Question: In one sentence, what is this figure communicating?
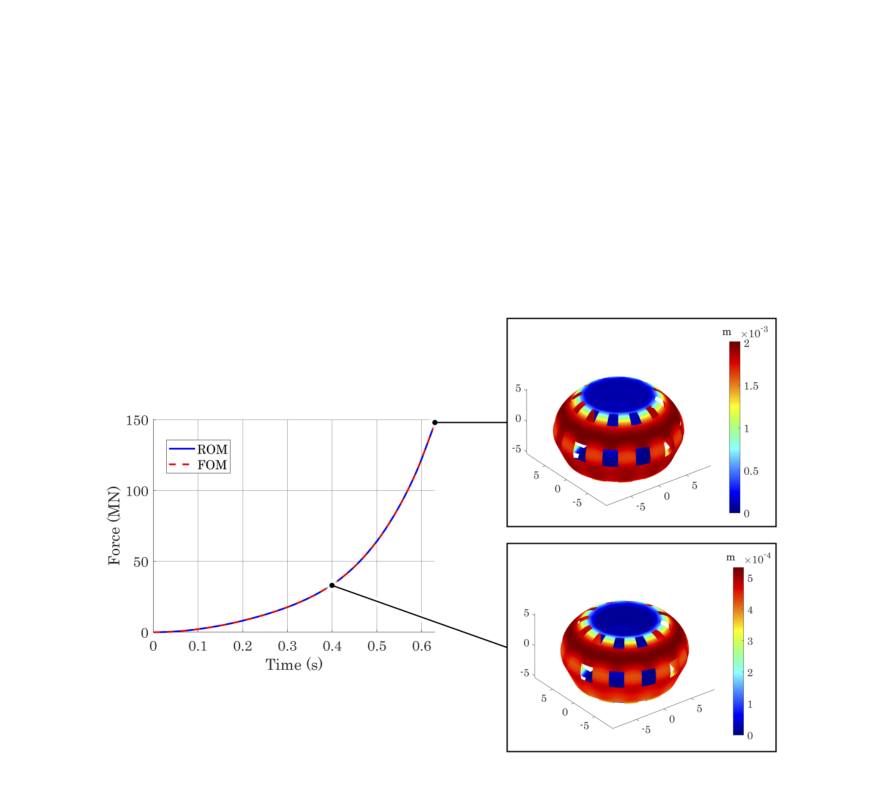
Answer: Trend of total force over the ITER-like Vacuum Vessel during the VDE evaluated with the FOM, and the ROM. The displacement magnitude is also reported at t = 0.4 s and at t = 0.63 s. Graphically the displacement is amplified by a factor α = 600.